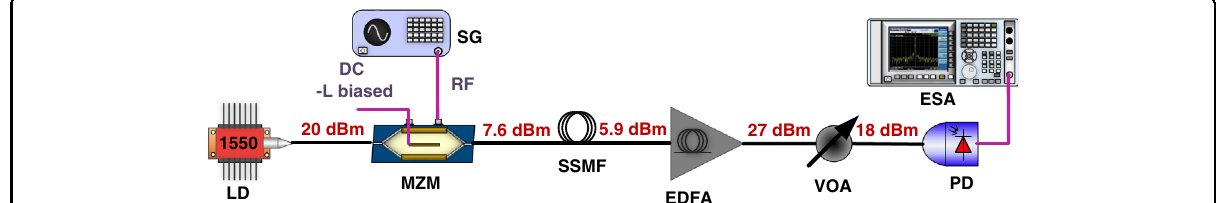
Fig. 6 Noise fi gure optimized (SBS-free) SSMF APL set-up. The MZM was L-biased, the input into the SSMF was kept well below the SBS threshold to avoid signal degradation, and the optical power prior to photodetection was boosted with a low-noise EDFA to raise the signal noise above the thermal noise. LD, laser diode; MZM, Mach-Zehnder modulator; EDFA, erbium-doped fi bre ampli fi er; SG, signal generator; VOA, variable optical attenuator; PD, photodiode; ESA, electrical spectrum analyzer. Details of the speci fi c components used are given in the ‘ Methods ’ section